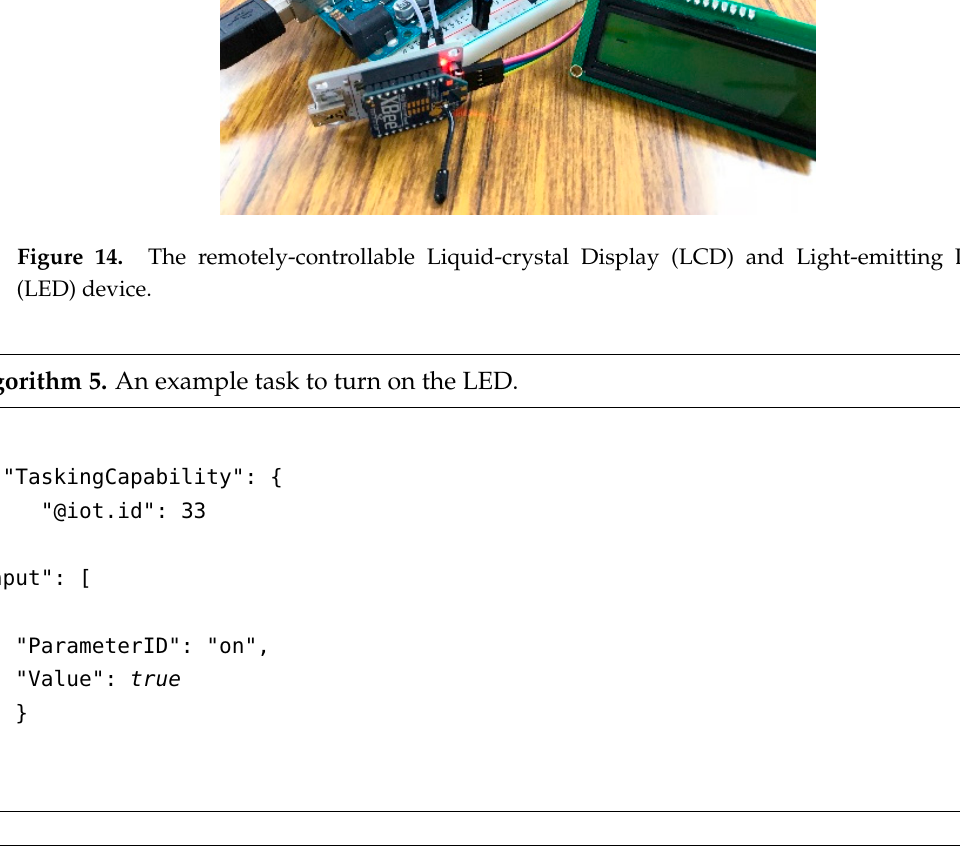
Algorithm 6. An example task to display text on the LCD